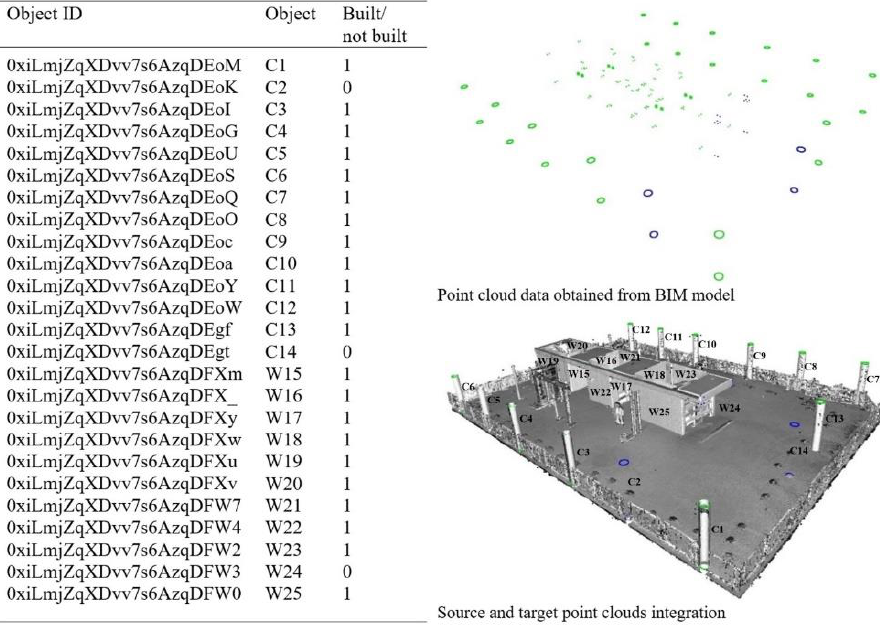
Figure 17. Reporting and visualization of results.